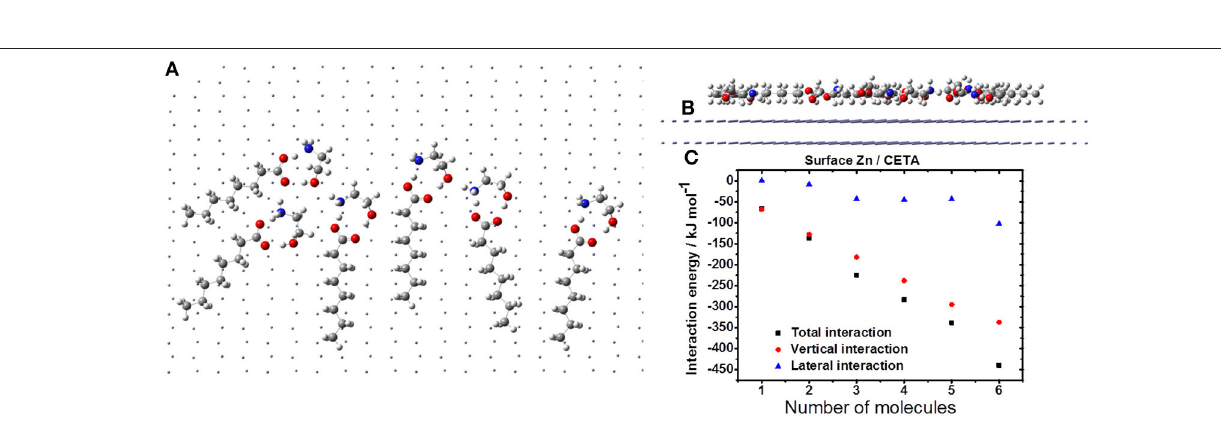
Frontiers in Chemistry | www.frontiersin.org